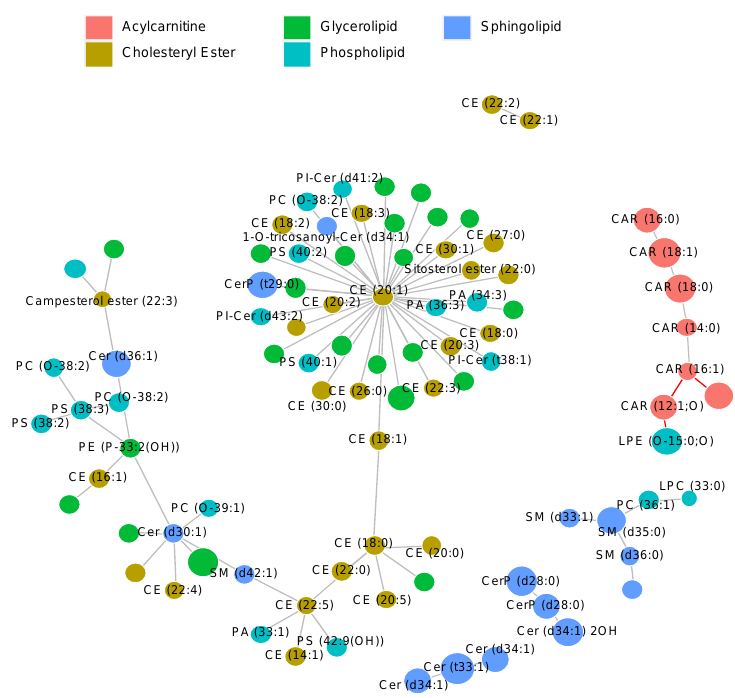
Figure 6. Correlation network demonstrating interdependence between lipid abundances measured in skin samples. The size of the circles illustrates the effect size (difference between the abundances observed in diseased animals and the healthy controls), whereas the edge lengths represent the strength of the correlation. The red edges denote a negative correlation. The data collected from the skin, especially from the lesional areas, are noisy, as many